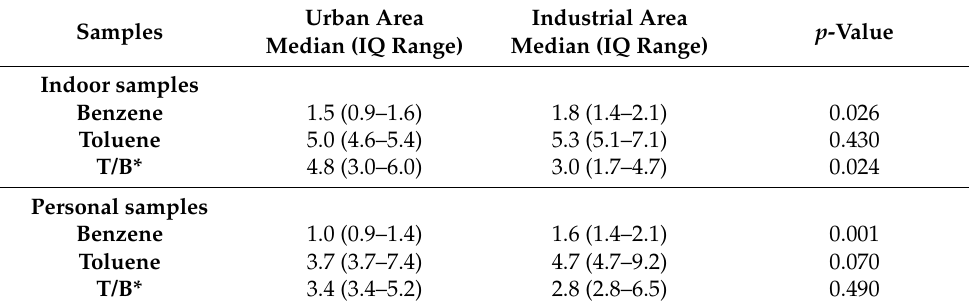
Table 4. Airborne benzene and toluene concentrations (expressed as µ g/m 3 ) in indoor and personal samples by study area.